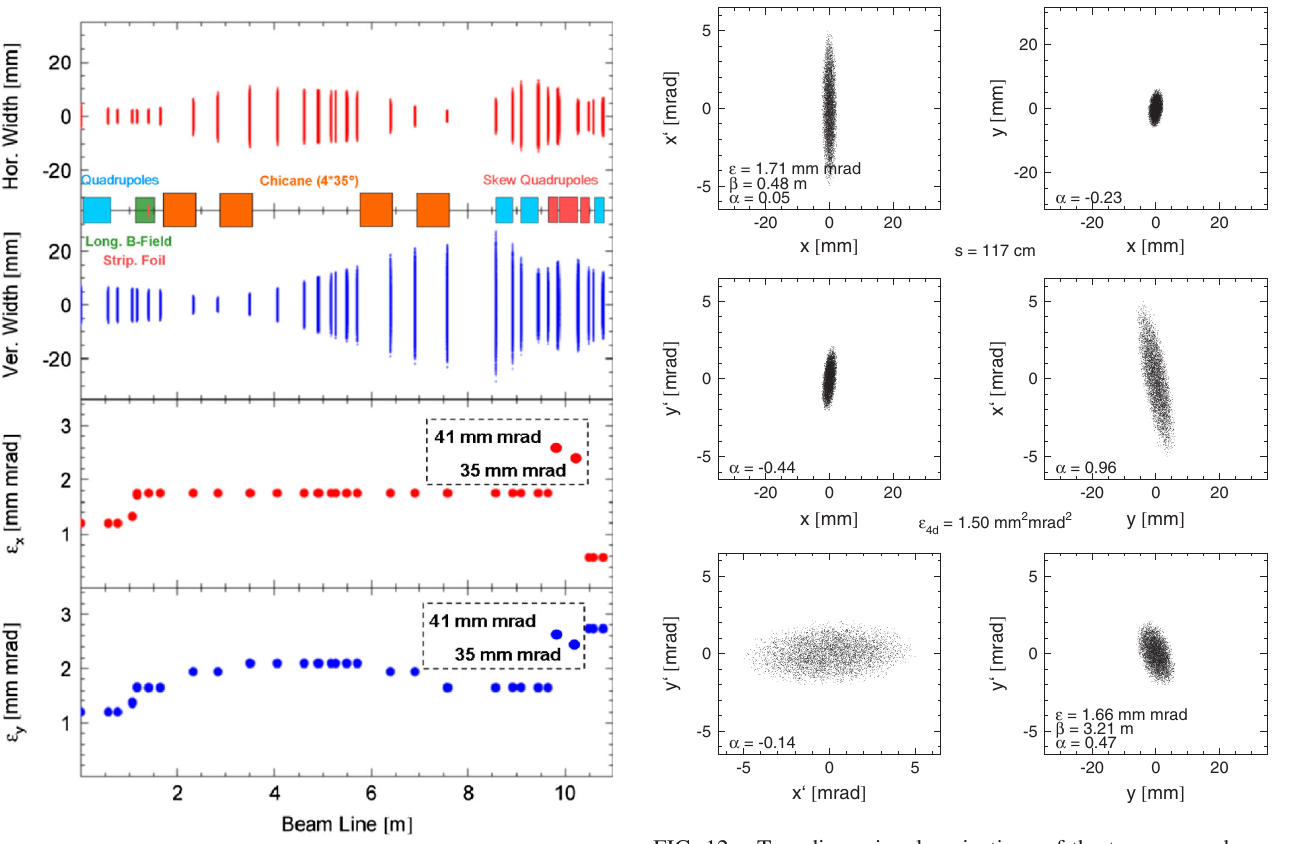
parameters.FIG. 11. From top to bottom: horizontal beam envelope, ver- tical beam envelope, horizontal rms emittance, and vertical rms emittance along the proposed emittance transfer section along the